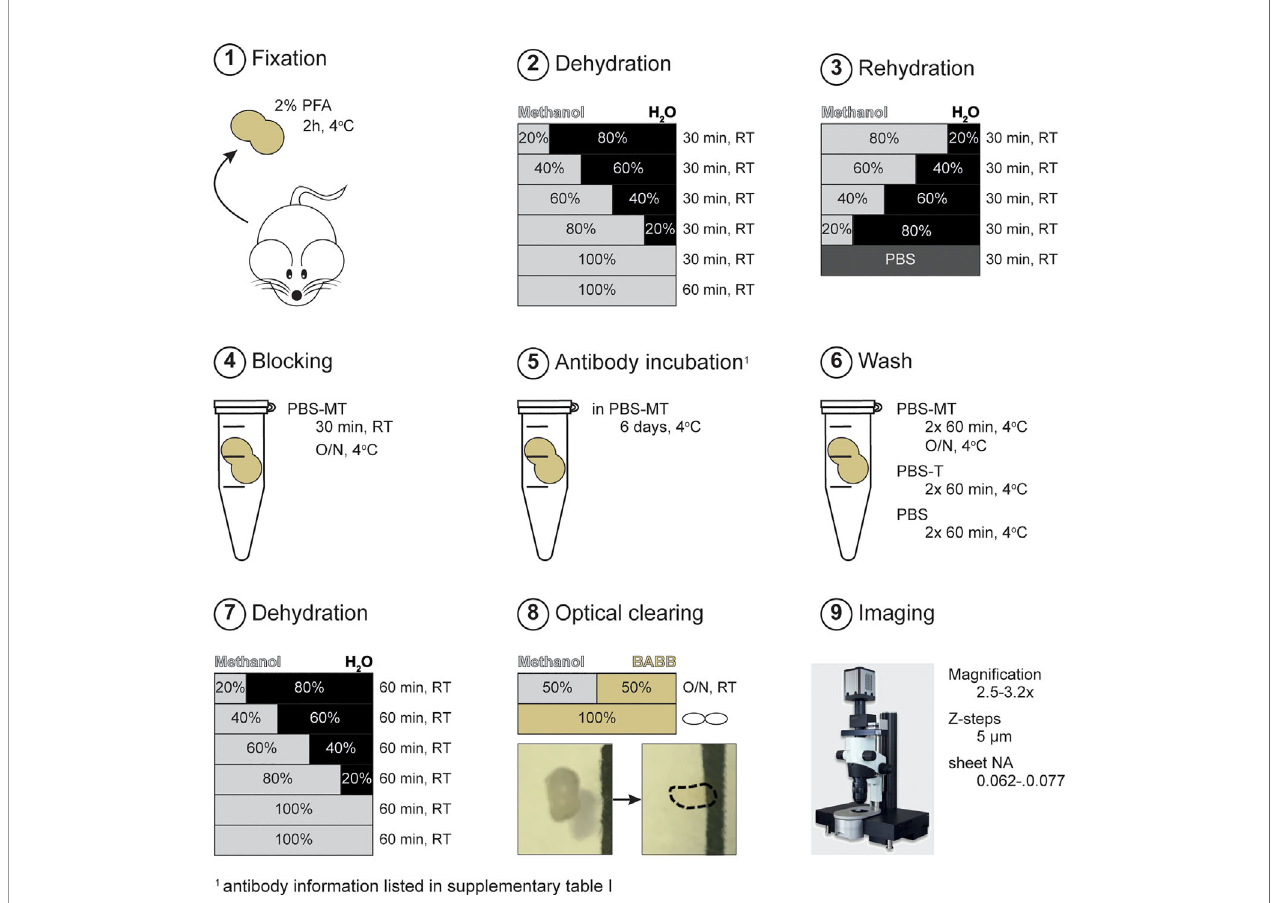
FIGURE 1 | Schematic representation of experimental procedure. After fi xation (step 1), samples were subjected to de- and rehydration using methanol/H 2 O series (step 2-3). Next, samples were overnight blocked with PBS-MT followed by antibody incubation (step 4-6). Sample clearing was achieved by methanol dehydration and incubation with BABB solution (step 7-8). Sample imaging was done using ultramicroscopy (step 9). PBS-MT; 1% skim-milk + 0.4% TritonX-100 in PBS. RT, room temperature; O/N,